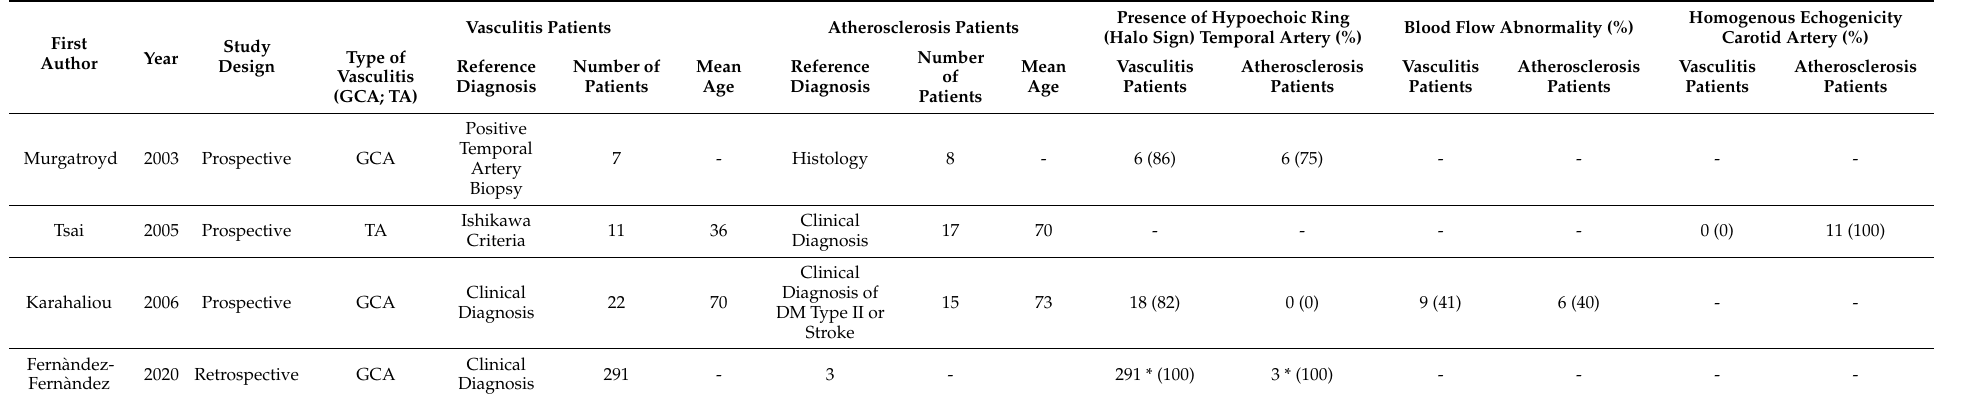
Table 2. Overview Outcome Parameters Ultrasound